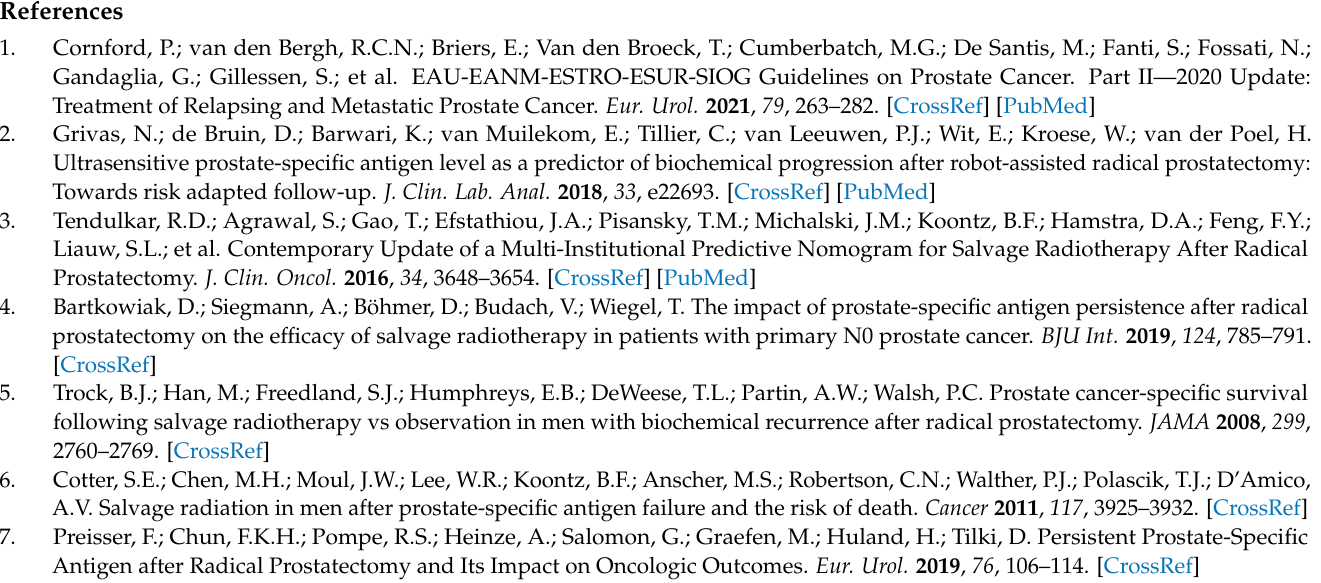
Table S1: Multivariable Cox regression predicting metastasis and death of patients with biochemical recurrence after radical prostatectomy and 1:1 matching, stratified according to salvage radiotherapy vs. observation, sensitivity analysis at 6